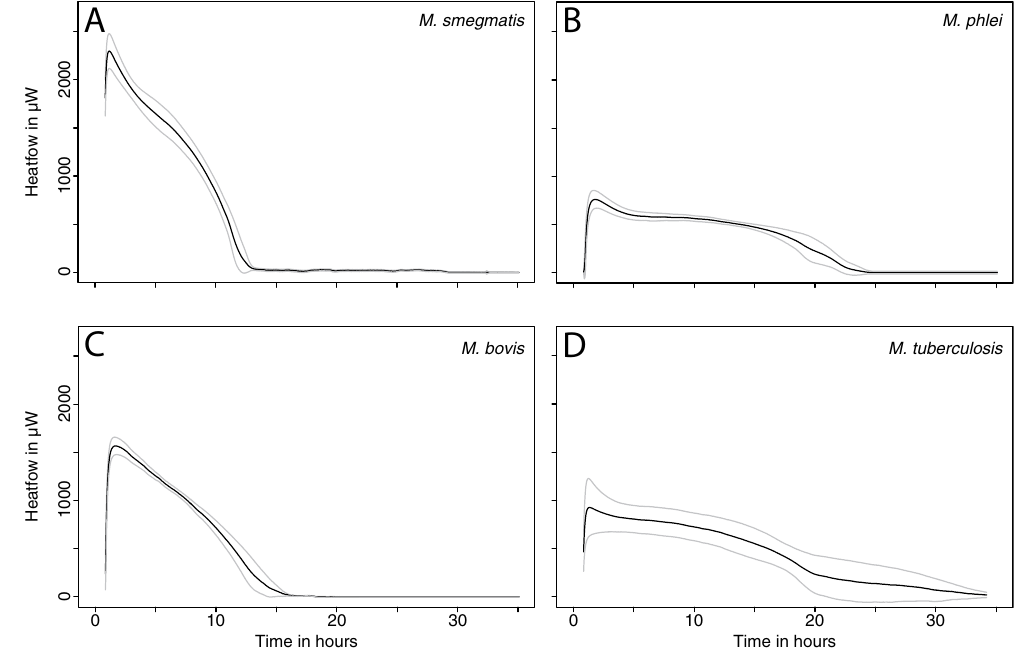
Figure 2. Metabolic heat production of the mycobacterial biofilms tested. ( A ) M. smegmatis , ( B ) M. phlei , ( C) M. bovis , ( D) M. tuberculosis . Black lines represent the average of 4 replicates and grey lines represent the upper and lower values of standard deviations. 7 replicates were performed for M. tuberculosis